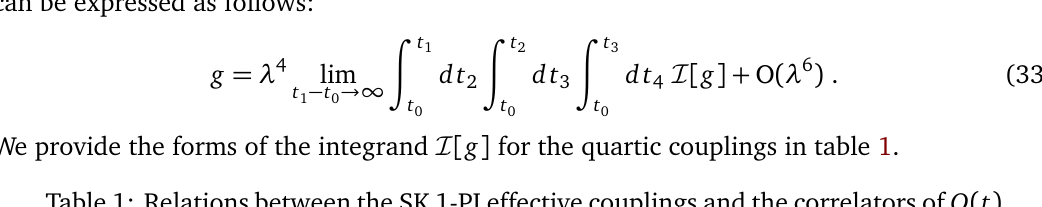
Table 1: Relations between the SK 1-PI effective couplings and the correlators of O ( t